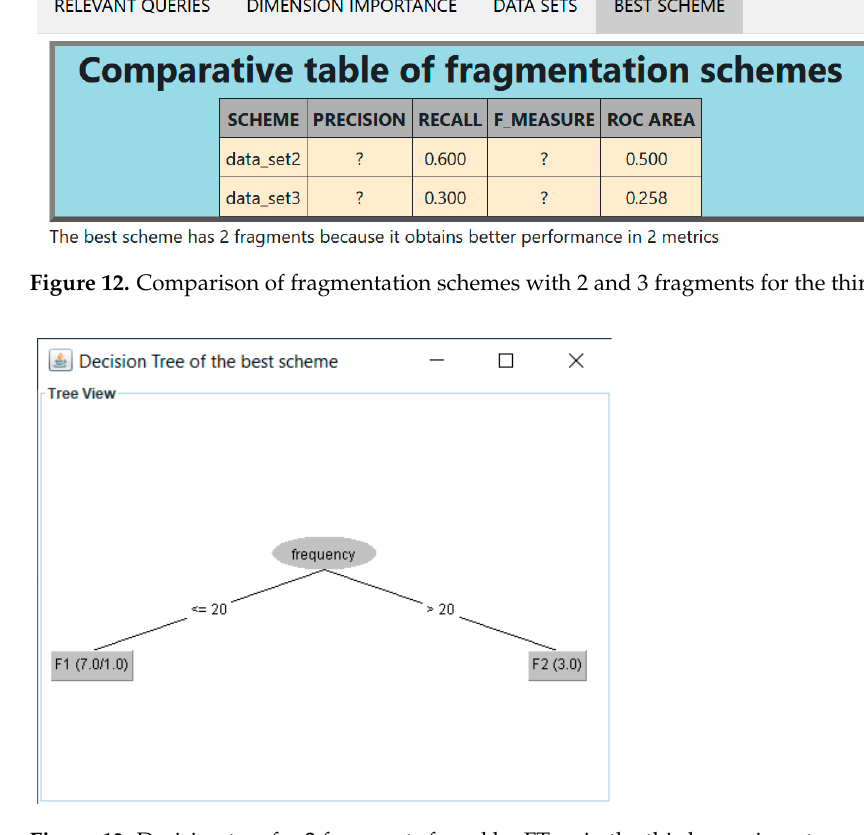
Table 17. Comparison of query costs for the two fragmentation schemes.